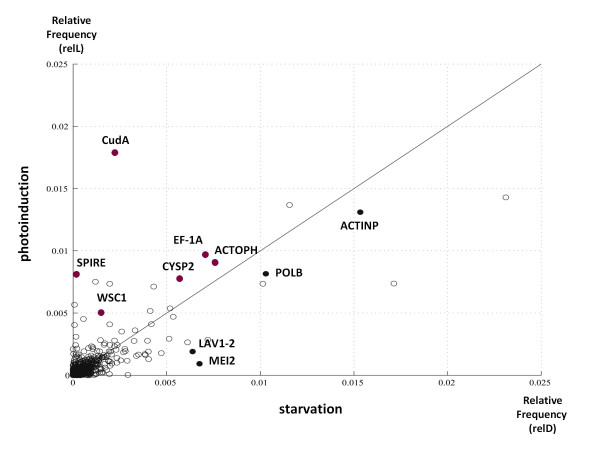
Relative frequencies of transcripts in libraries prepared from competent and photoinduced plasmodia. Each circle represents a single cDNA, plotted according to its relative frequencies (number of hits per transcript divided by the total number of hits) on each cDNA library. relL and relD represent the relative frequencies in the libraries prepared from light-induced and competent plasmodia, respectively. Transcripts more abundant in light-induced (above the diagonal) or in competent, not light-induced plasmodia (below the diagonal) are shown, and SwissProt orthologs are indicated for 10 contigs with relative frequencies greater than 0.005. Red dots represent those contigs which are more abundant in the light-induced plasmodial library, and black those which are more abundant in the library prepared from competent plasmodia. Detailed descriptions for these transcripts can be found on the Table S1.